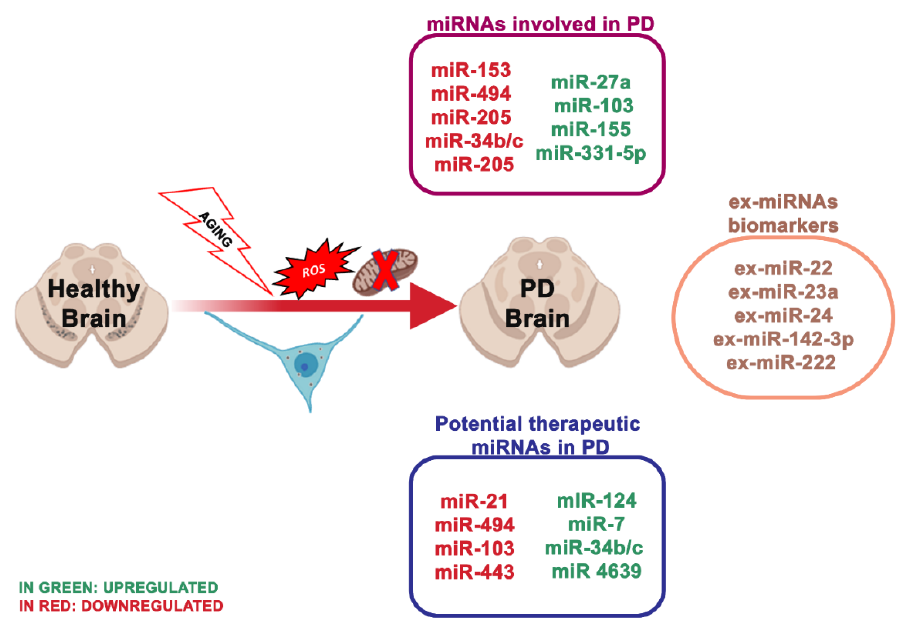
Figure 2. The most essential miRNAs involved in Parkinson’s disease.